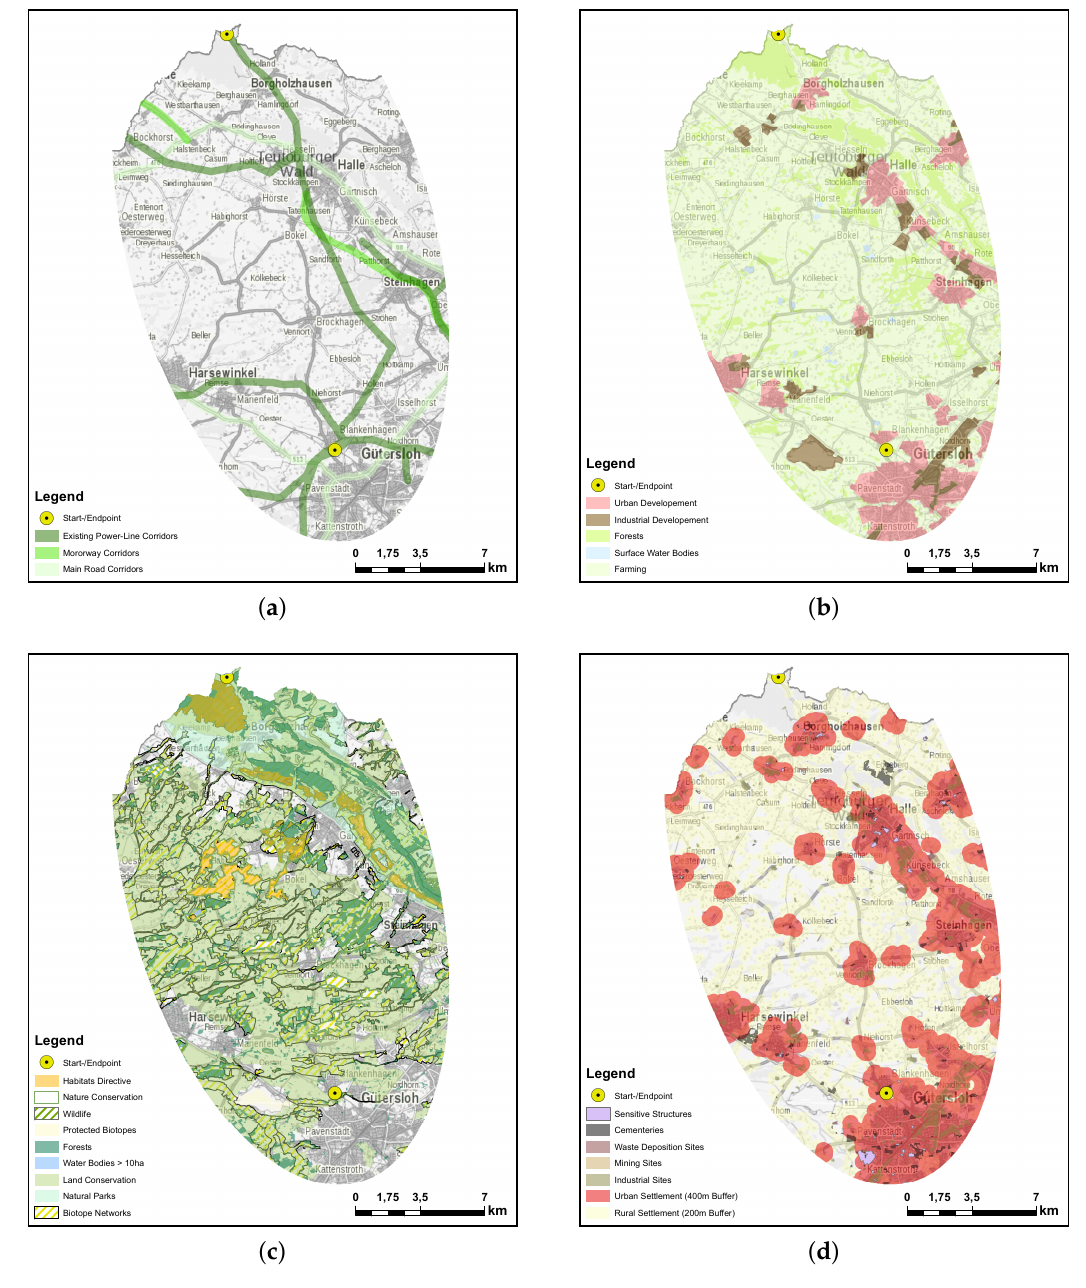
Figure 5. Criteria used to model the impact of power-line routings in the study area. Criteria are categorised into four categories of protective goods. Data copyright by GeoBasis-DE/BKG 2017 . ( a ) 200m buffers of linear infrastructures (positive impact); ( b ) Regional Planning Regulations (negative impact); ( c ) Nature and Environmental Protection areas (negative impact); ( d ) Settlement Structures and Urban Land Use (negative